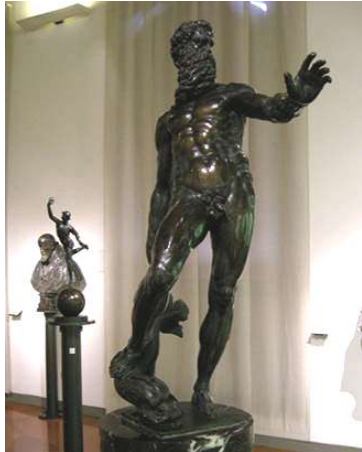
Figure 3. The archetype of the statue of Neptune, exhibited at the Civic Medieval Museum of